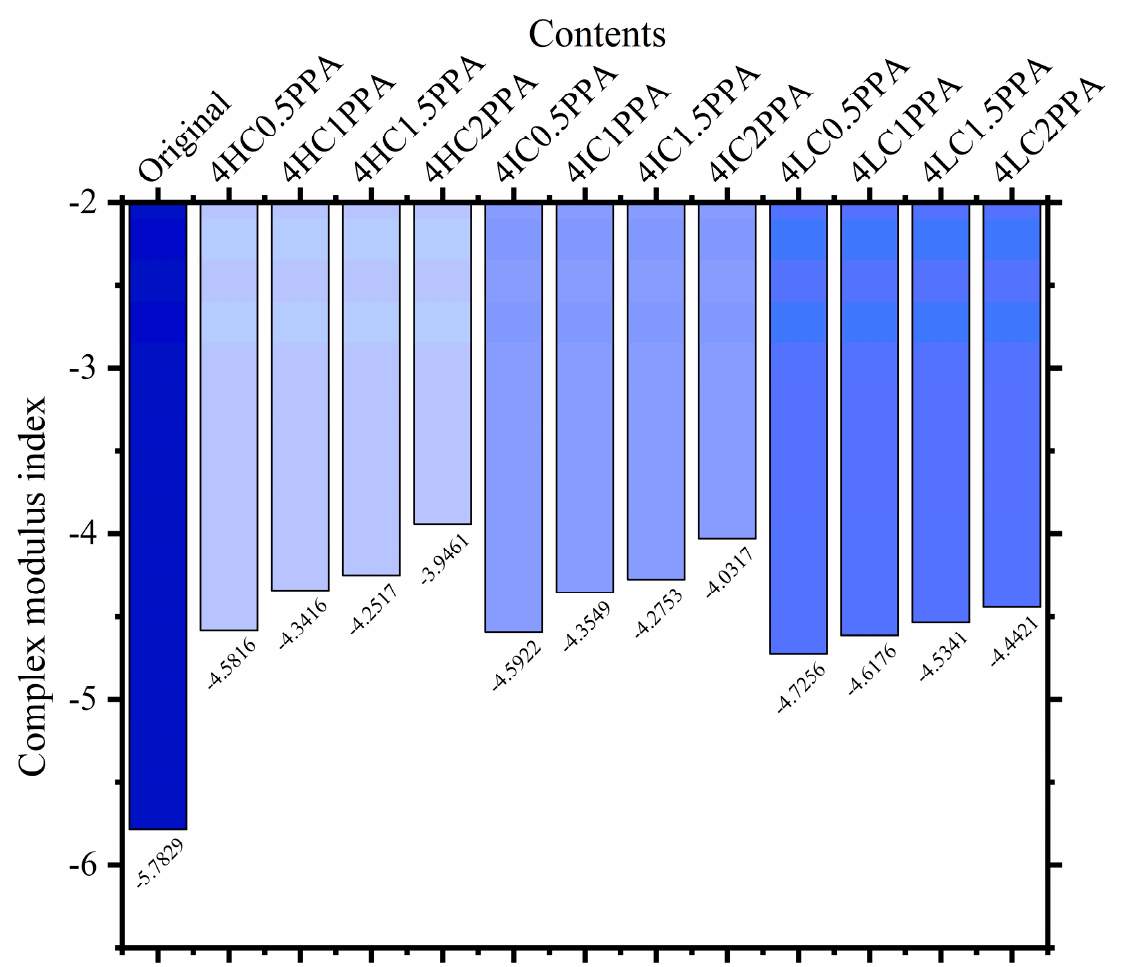
Figure 7. The complex modulus index of different types of bitumen.